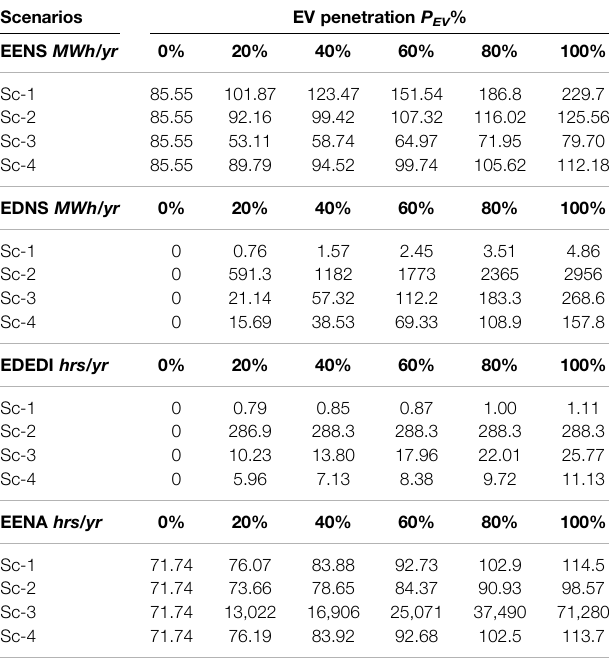
TABLE 7 | The output of EENS, EDNS, EDEDI and EENA in Sc-1, Sc-2, Sc-3 and Sc-4 across different EV penetration levels. Scenarios